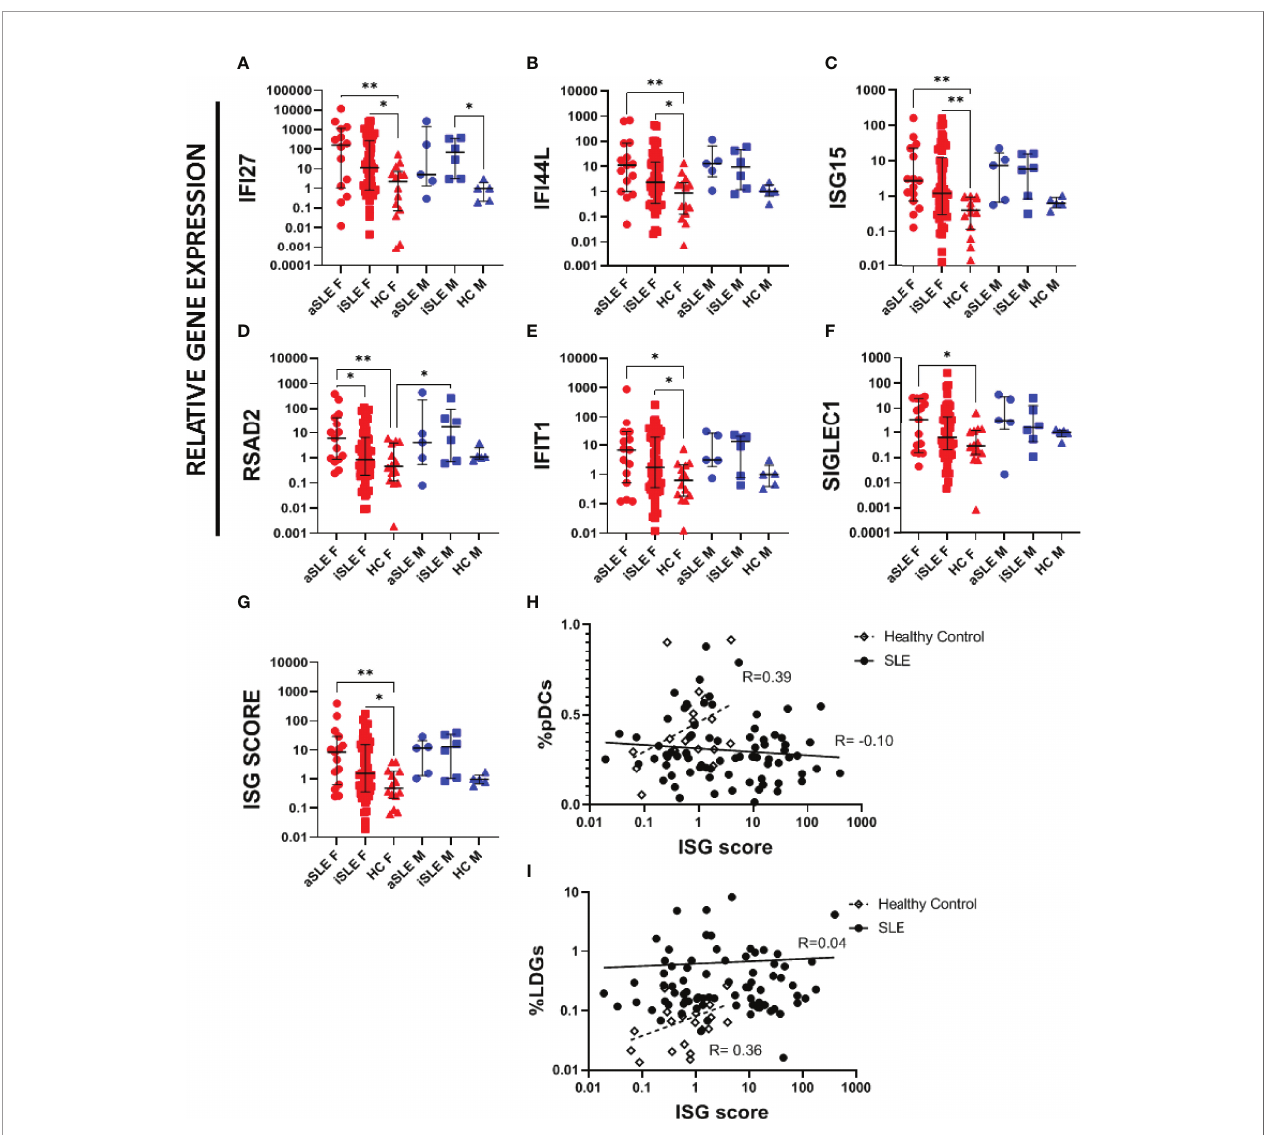
Table2,pDCassociatedcytokineexpressionisvariableamongSLEpatients. AsubsetofserumsampleswereanalyzedforcytokineexpressionusingLegendplexbeadassayfollowingkit protocol. Data represents mean ± SD. *p value compared to sex-matched healthy control. *p < 0.05; **p <